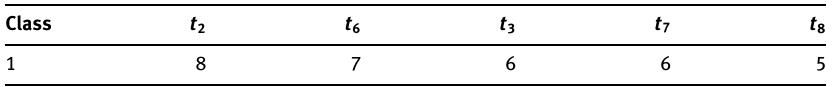
Table 6: Selecting N ′ = 5 for Class 1.